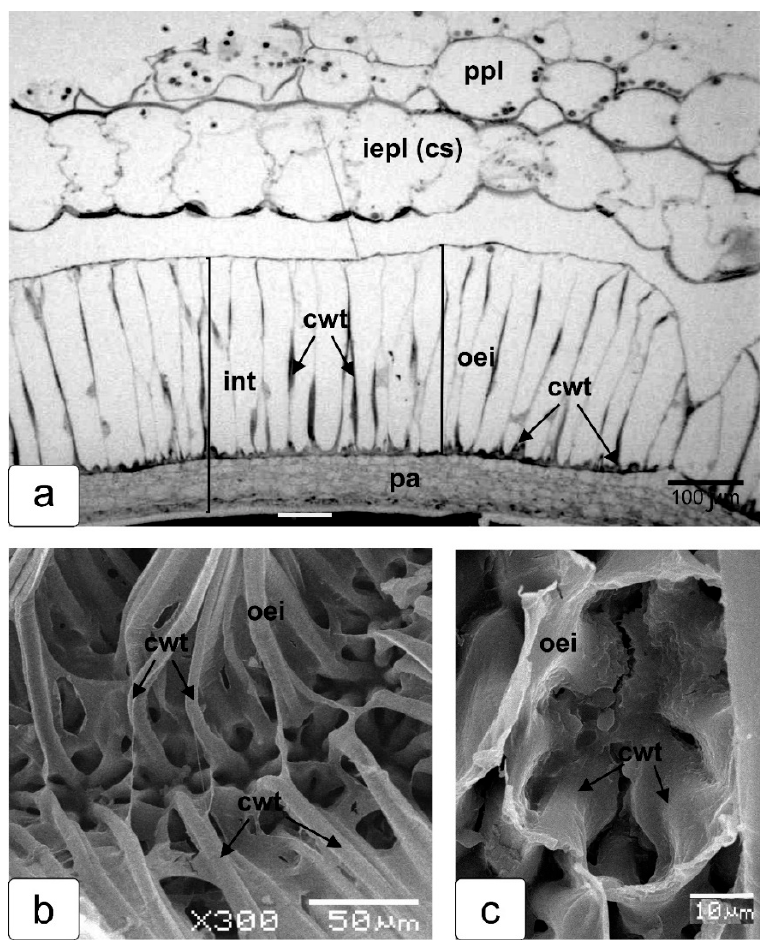
Figure 6. Fragment of an anatomical cross section of the tomato seed coat, together with part of the shell of the emerging seed capsule. The walls of elongated cells, which forming the coat outer layer of a mature seed have thickenings at the base, turning into local thickenings, a kind of cell wall, which can be traced throughout the cell stretch ( a ). After the seed dries up and is released from the capsule, these elongated cells crack in extended sections of cell walls (having no secondary cell walls) between these "ribs" into separate ribbons ( b ). Thickened fragments formed by deposits of the secondary cell wall are clearly visible at the base of each cell and other surfaces ( c ). Designations: cs—capsule shell (iepl—inner epidermis of the protrusion of placental tissue); cwt—cell wall thickening; oei—outer epidermis of integument; ppl—protrusion placenta